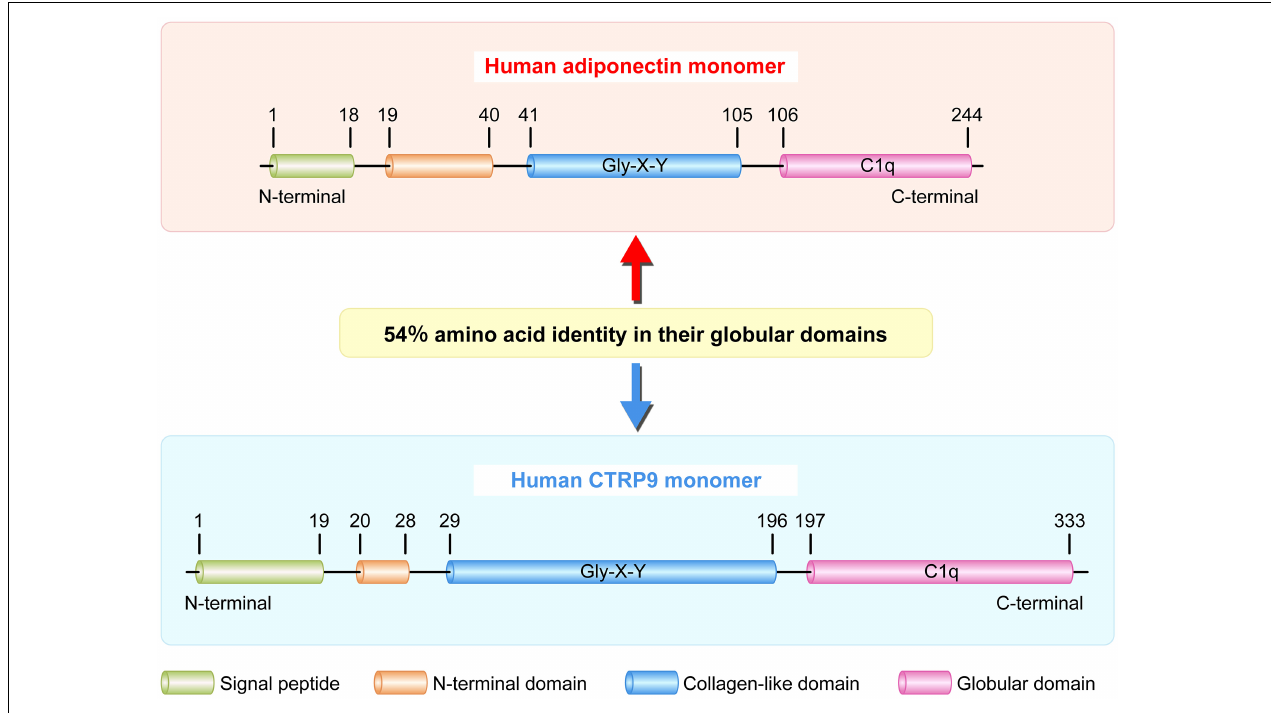
FIGURE 2 | Schematic of human adiponectin and CTRP9 monomer structure. Human adiponectin and CTRP9 monomers are composed of four regions: a signal peptide, an N-terminal domain, a collagen-like domain with multiple Gly-X-Y repeats, and a C-terminal globular domain homologous to the immune complement C1q. These two adipokines share 54% amino acid identity in their globular domains. CTRP9, C1q tumor necrosis factor-related protein